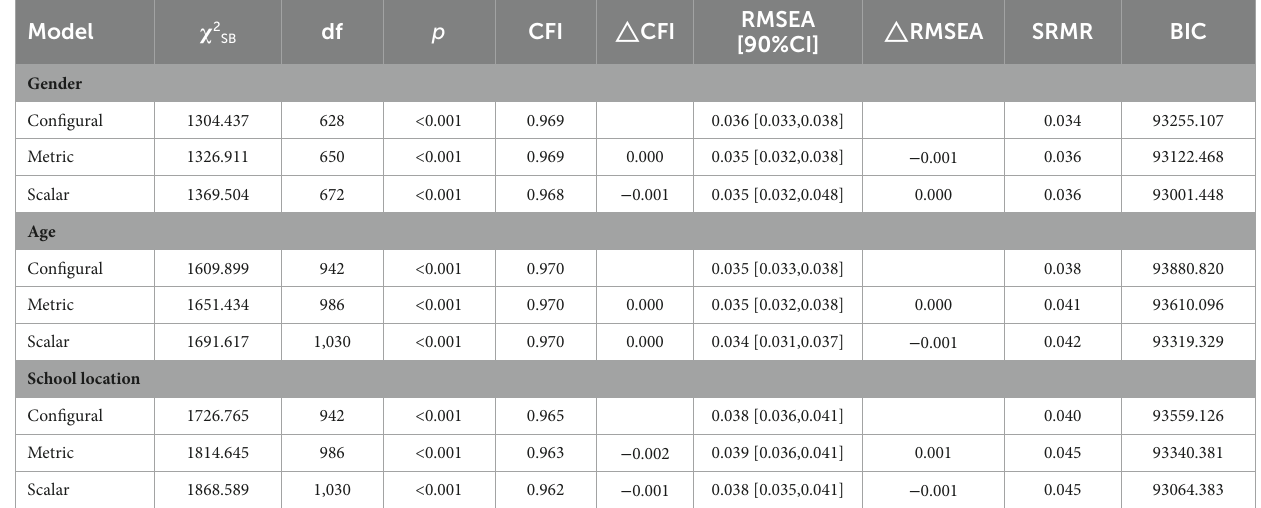
TABLE 6 Results of invariance analysis.